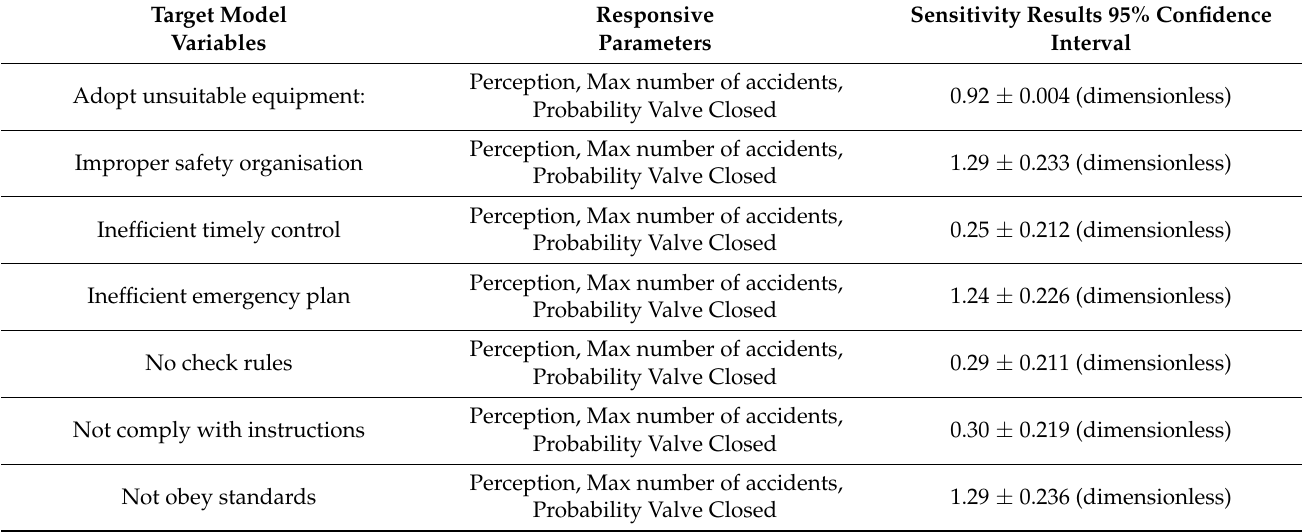
Table 8. Results of Monte Carlo Sensitivity analysis of responsive